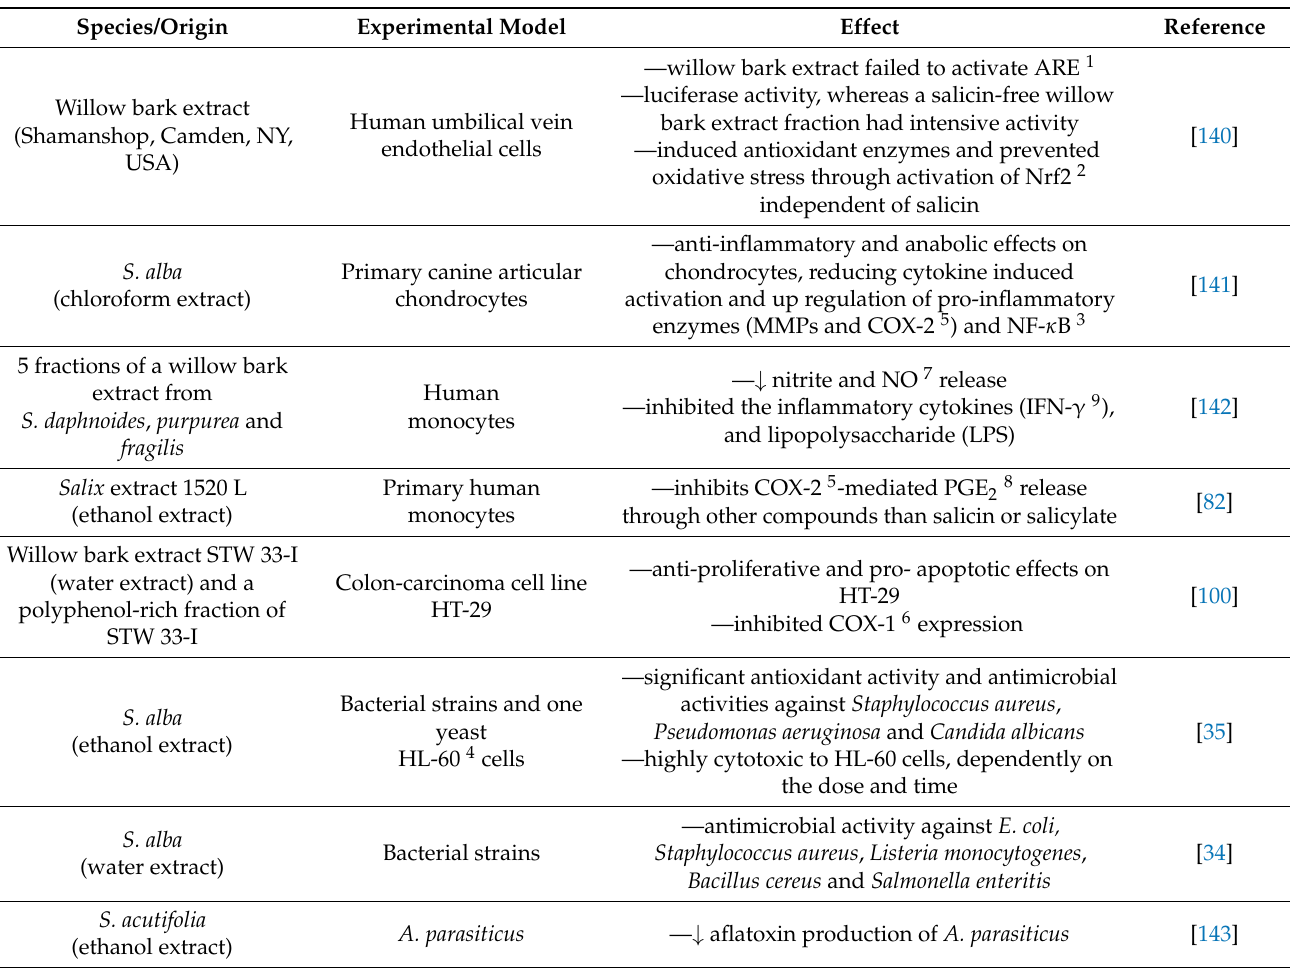
Table 3. In vitro studies on the effects of the bark of Salix species on different experimental